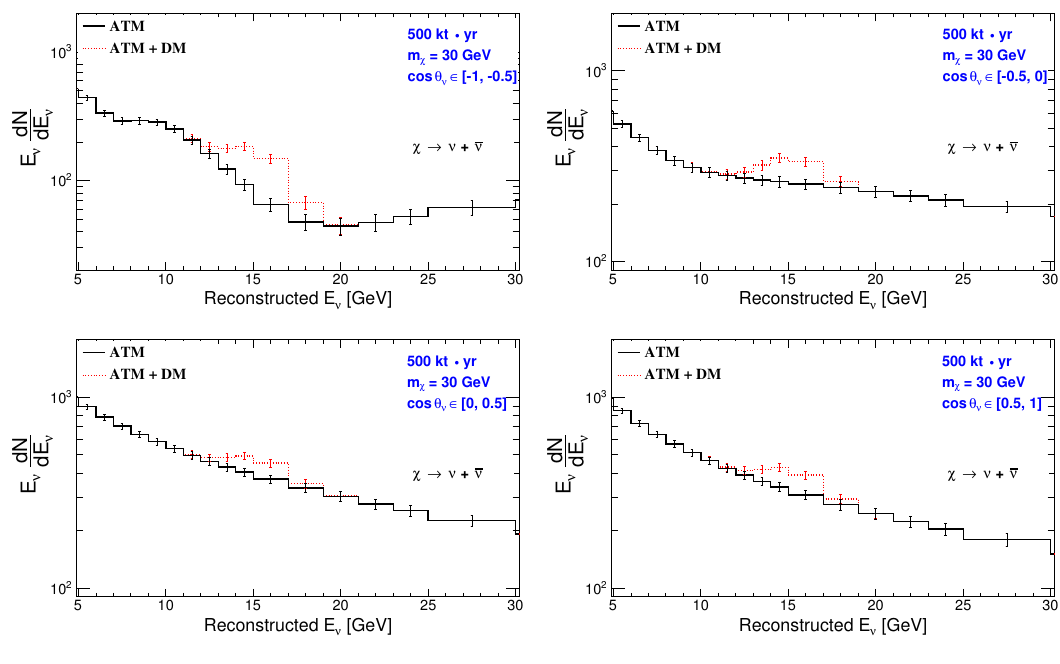
Figure 6. The event distribution of atmospheric (cid:23) (cid:22) (denoted as ATM) and the predicted (cid:23) (cid:22) event spectra in presence of decay of 30 GeV dark matter particles (denoted as ATM + DM) in di(cid:11)erent cos (cid:18) (cid:23) ranges using 500 kt (cid:1) yr exposure of the MagICAL detector. Black solid (red dotted) line represents the ATM (ATM + DM). The mass ordering is taken as NO. The lifetime of dark matter is arbitrarily chosen (4.7 (cid:2) 10 24 s) for sake of visual clarity.